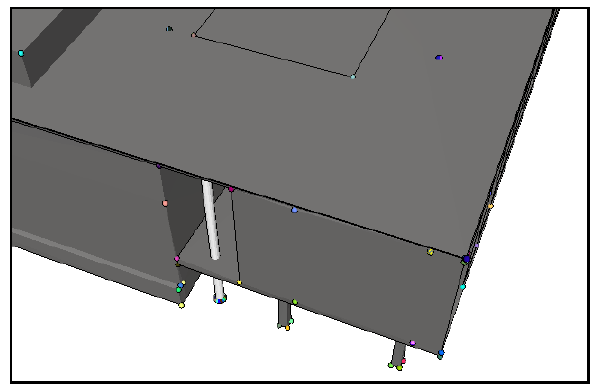
Figure 12. Colour-coded Ground Control Points visible in the synthetic